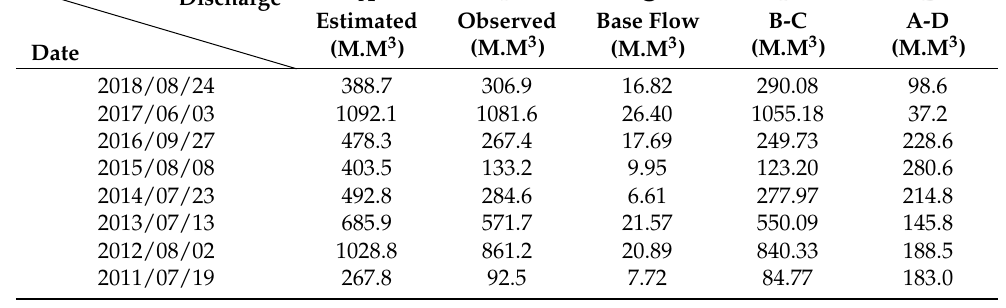
Figure 6. Location of the flow station. Table 4. Observation and estimation of the maximum discharge events in each year.